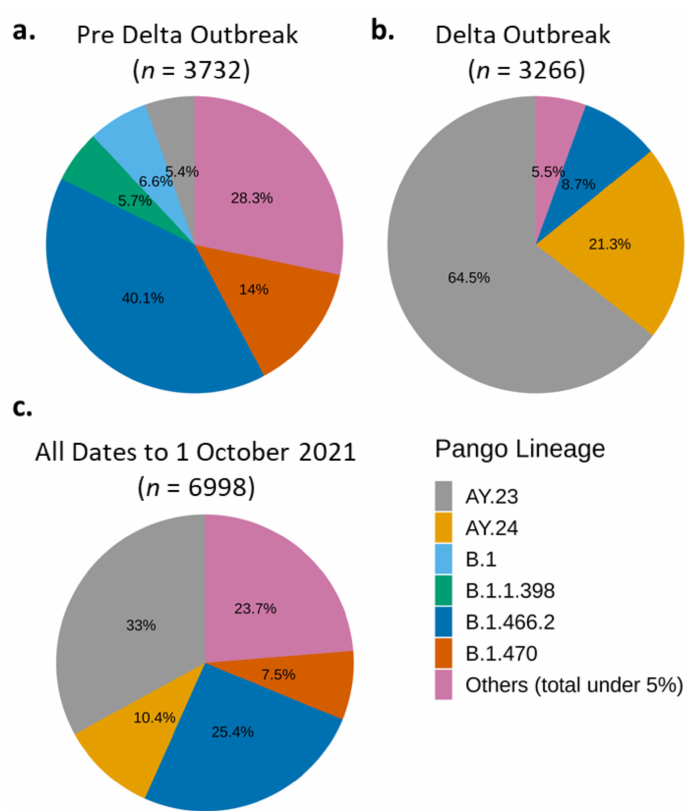
Figure 3. Predominant SARS-CoV-2 variants in Indonesia during pre-Delta (1 March–1 June 2020) and Delta (2 June–1 October 2022) periods. B.1.466.2 and AY.23 (Delta sub-lineage) were the dominant variant during pre-Delta ( a ) and Delta ( b ) period, respectively. Variant AY.23 followed by B.1.466.2 were the most dominant variant during all periods ( c